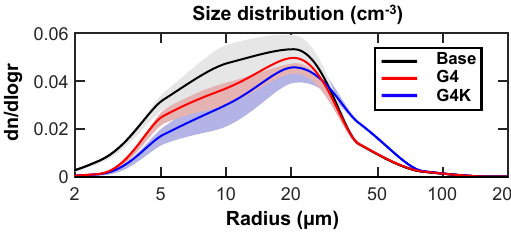
Figure 11. Zonally and time-averaged total number density val- ues of ice crystals as a function of latitude ( n , cm − 3 ) (years 2030–2069), as calculated in the ULAQ-CCM (for Base, G4, G4K experiments) and compared with indirectly derived values from the MERRA-2 and ERA5 ice mass mixing ratio and ULAQ- CCM (Eq. 4). Number densities are calculated at pressure layers 150–200hPa for 25 ◦ S–25 ◦ N, 200–250hPa for 25–35 ◦ N/S, 250–